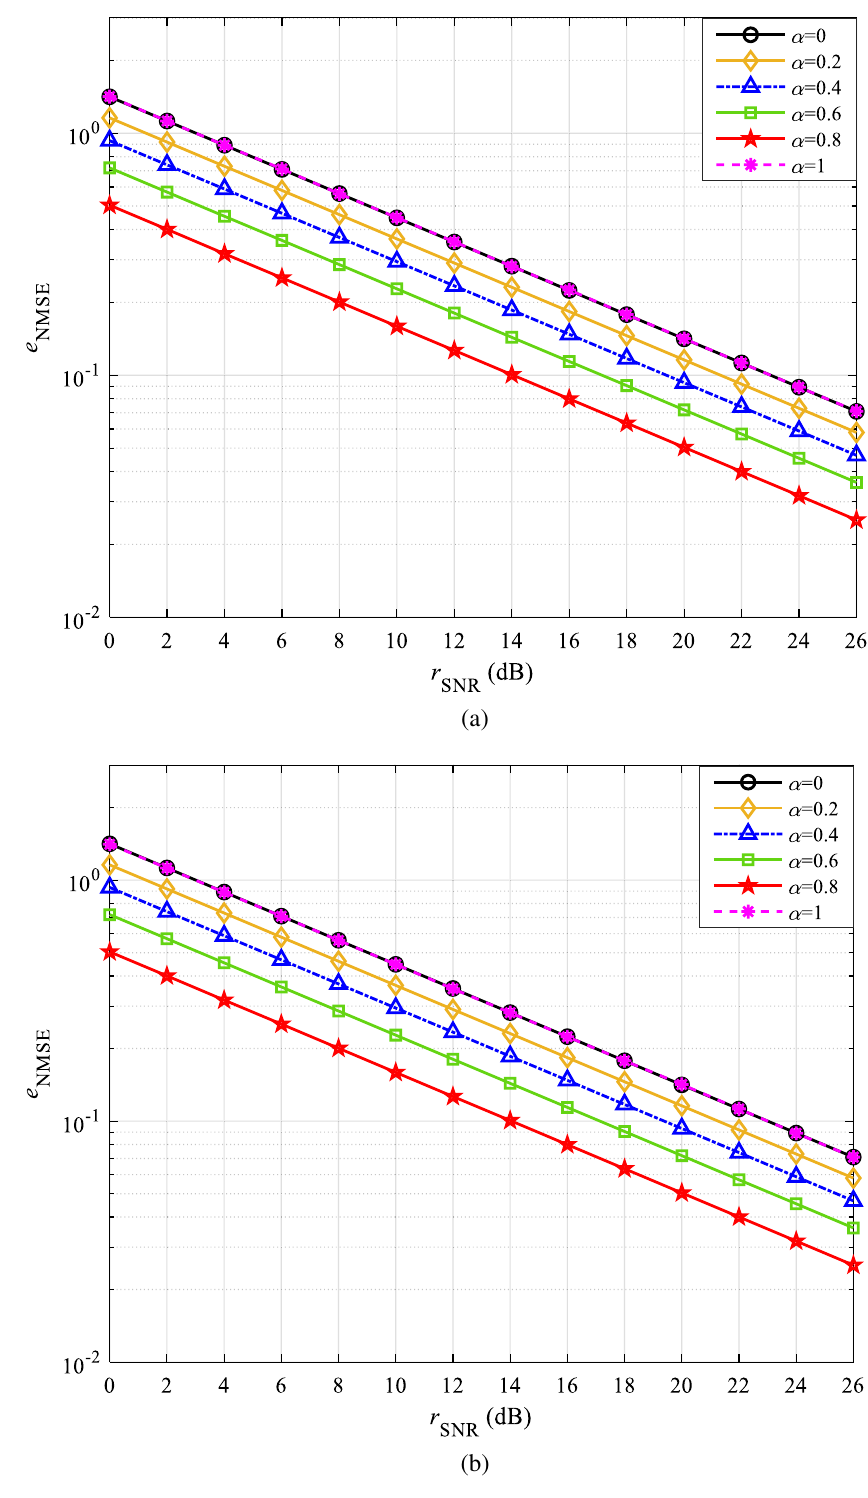
Figure 3. NMSE curves with α within 0 to 1: (a ) CDT 1 and ( b ) CDT